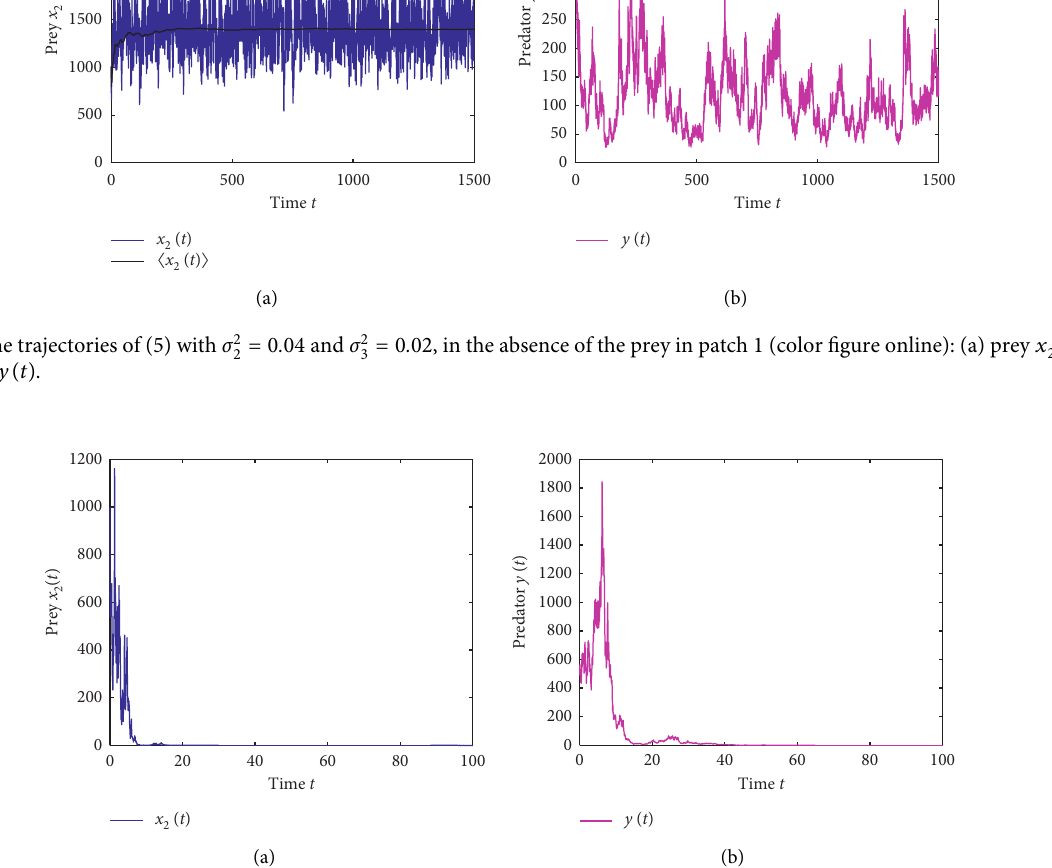
� 1 . 24 and σ 2 � 0 . 2, in the absence of the prey in patch 1 (color figure online): (a) prey x 2 3